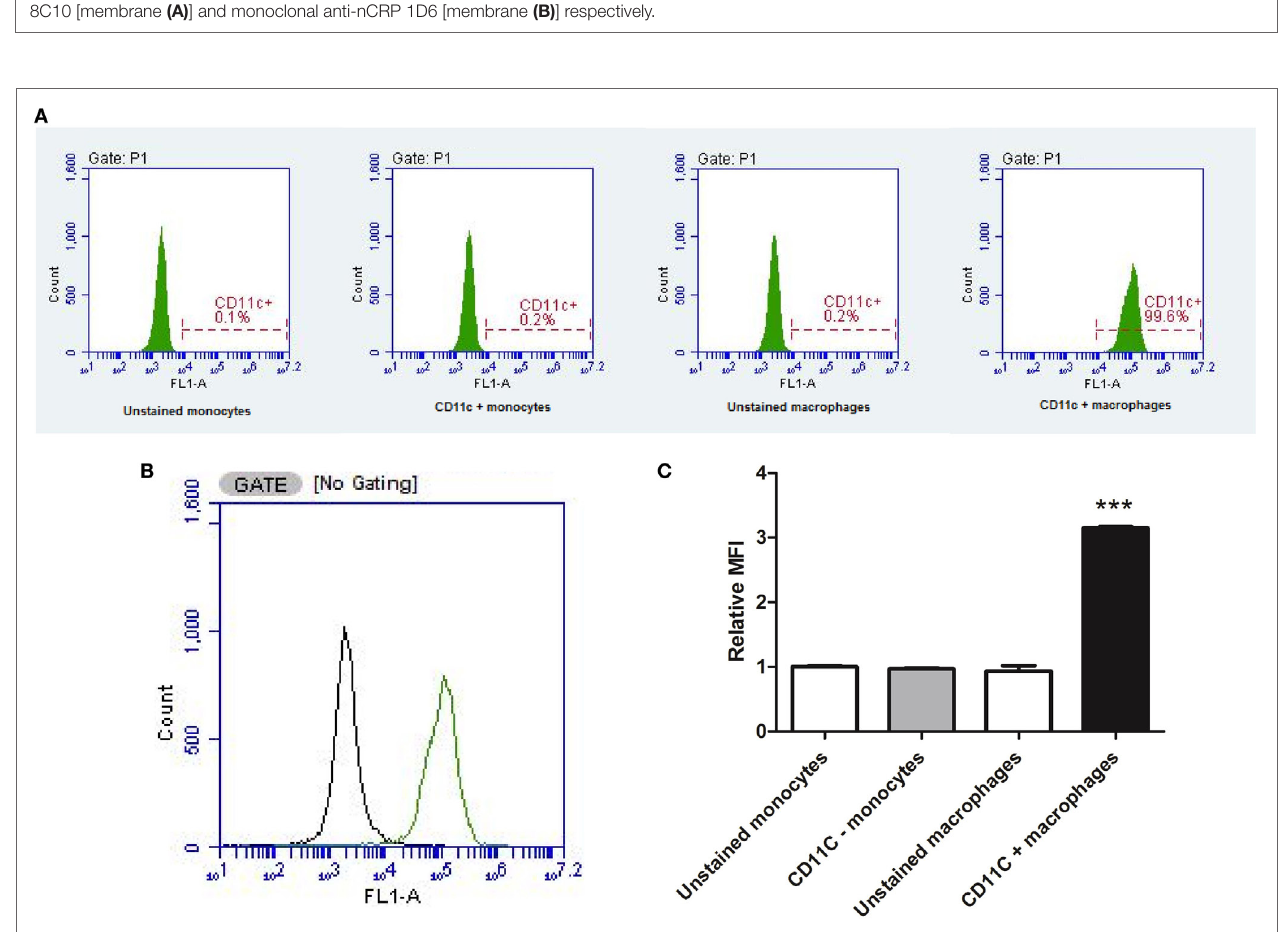
FigUre 3 | Flow cytometry confirming macrophage differentiation. The conversion of U937 monocytic cells into a distinct population of macrophage was confirmed via detection of the CD11c surface marker by flow cytometry (data represent an average of three independent experiments). Phorbol 12-myristate 13-acetate- differentiated cells almost exclusively expressed the CD11c macrophage marker, whereas monocytes predominantly lacked the CD11c surface marker (a) . Two distinct populations of cells were detected (B) with significantly higher median fluorescence intensity (MFI) in PMA-treated cells compared to undifferentiated U937 monocytes (c) . ***Indicates significant difference in MFI ( P < 0.001; n = 3). Errors bars represent the